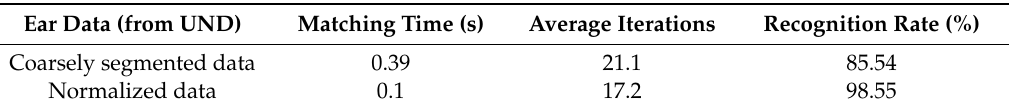
Table 3. Comparison of recognition result using different ear data.